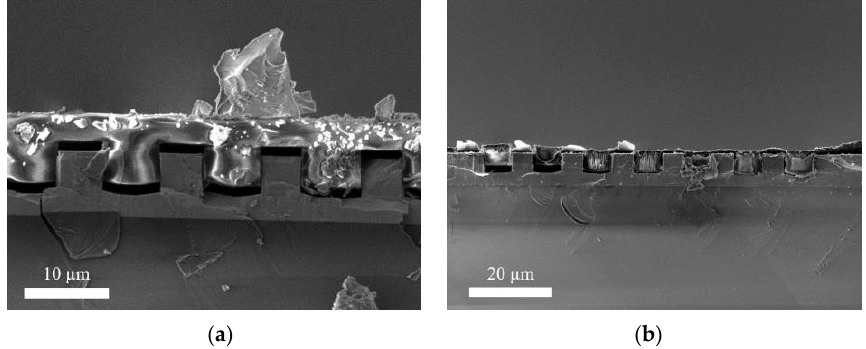
Figure 4. Cross section of planarized fins directly after spin-on and hard bake ( a ) and ICP etching ( b ). The trenches are filled